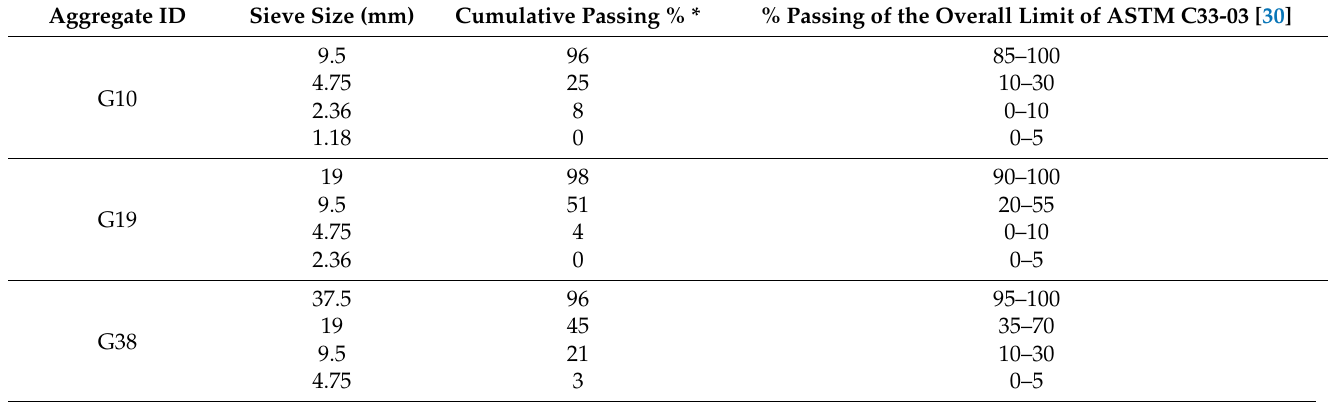
Table 4. Sieve analysis of the coarse aggregate.